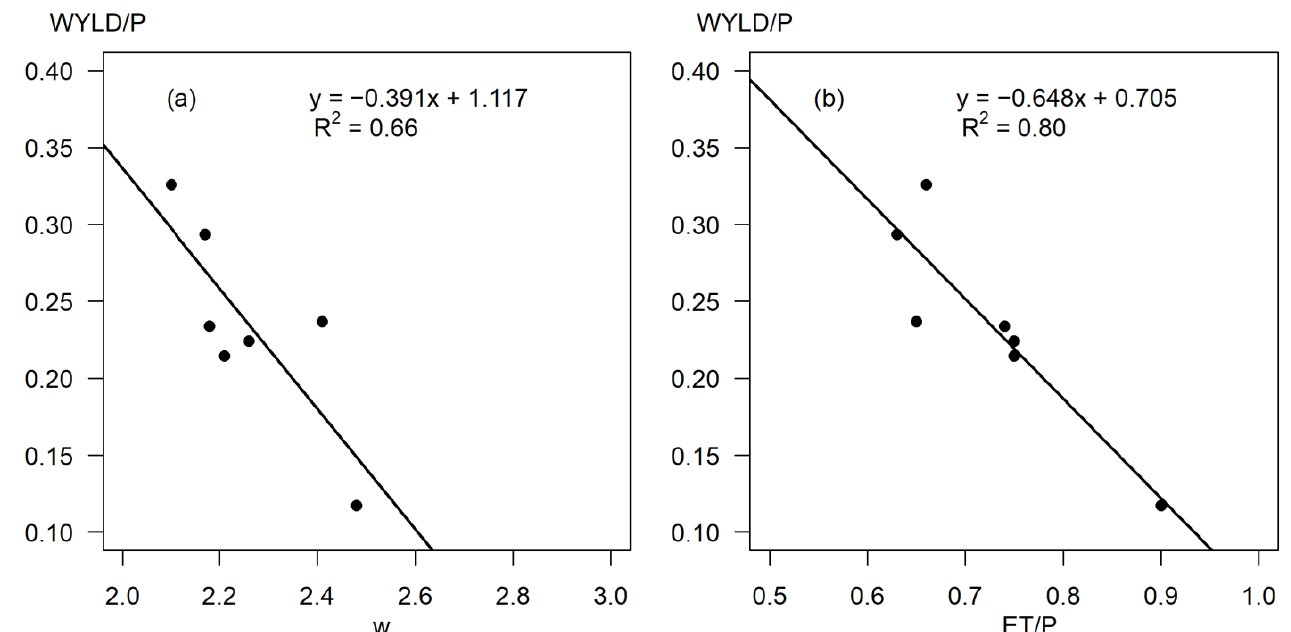
Figure 13. ( a ) The correlation between the optimized Fu w values and the runoff coefficient (WYLD/P) across several watersheds. ( b ) The correlation between the mean annual runoff coefficient and the evaporative index (ET/P). Note that this illustration is derived from Figure 12.